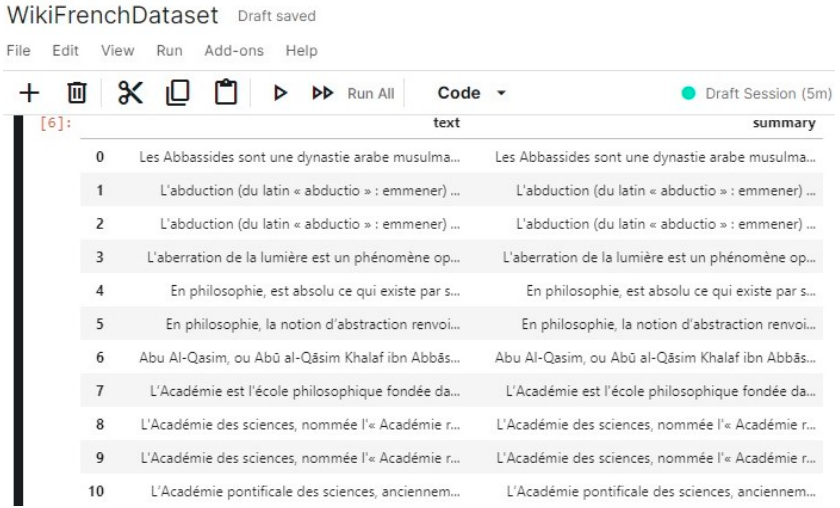
Figure A1. An excerpt of the dataset.